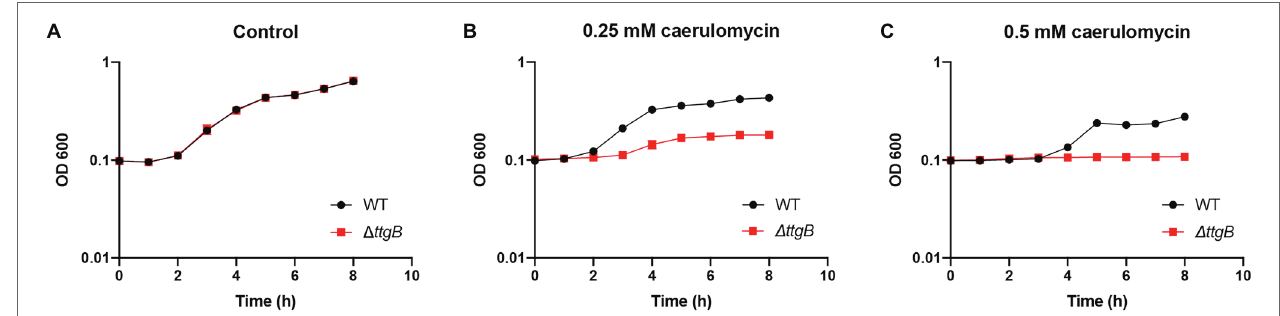
FIGURE 2 | Caerulomycin A inhibits growth when TtgABC is inactive. (A) Bacterial growth was analyzed in KB medium without supplementation and (B) in presence of 0.25 mM or (C) 0.5 mM caerulomycin A. To that end, overnight cultures were used to inoculate 100 μ l of KB medium in a 96-well plate. Growth curves were recorded by measuring OD600 using a Tecan reader (Tecan infinite ® M200 pro plate reader, settings: 30 ° C, shaking with an orbital amplitude of 2 mm). All experiments were performed a minimum of three